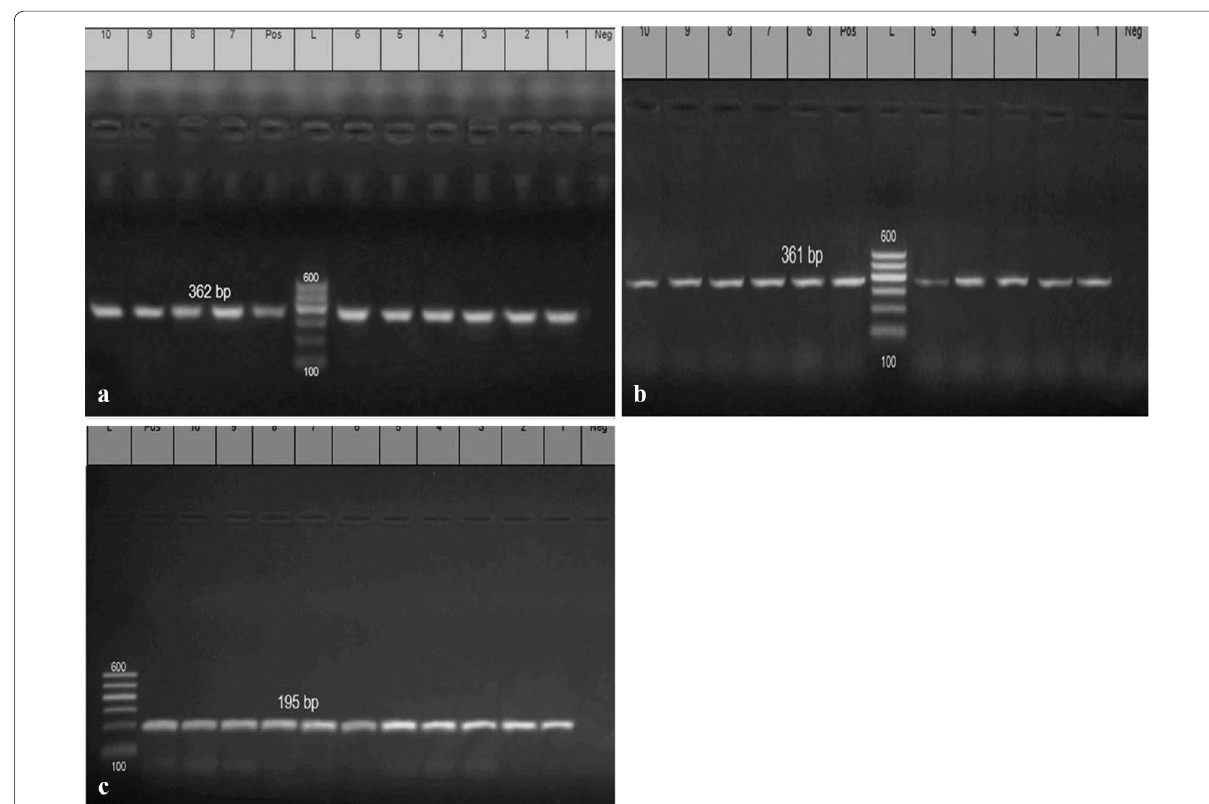
Fig. 2 Electrophoretic pattern of PCR products of E. coli qacEΔ1, QacA/B , and QacC/D genes: a (L): the DNA molecular size ladder (Gelpilot 100 bp ladder); (Neg.): negative control; (Pos.): positive control; (lanes 1, 2, 3, 4, 5, 6, 7, 8, 9 and 10): positive amplification of 362 bp of qacEΔ1 gene of different E. coli strains. b (L): the DNA molecular size ladder (Gelpilot 100 bp ladder); (Neg.): negative control; (Pos.): positive control; (lanes 1, 2, 3, 4, 5, 6, 7, 8, 9 and 10): positive amplification of 361 bp of qacA/B gene of different E. coli strains. c (L): the DNA molecular size ladder (Gelpilot 100 bp ladder); (Neg.): negative control; (Pos.): positive control; (lanes 1, 2, 3, 4, 5, 6, 7, 8, 9 and 10): positive amplification of 195 bp of qacC/D gene of different E. coli